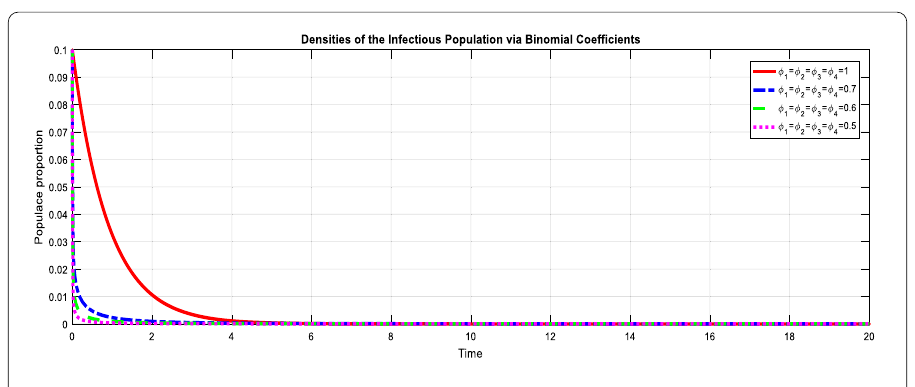
Figure 19 Dynamic of I ( t ) by varying the value of φ